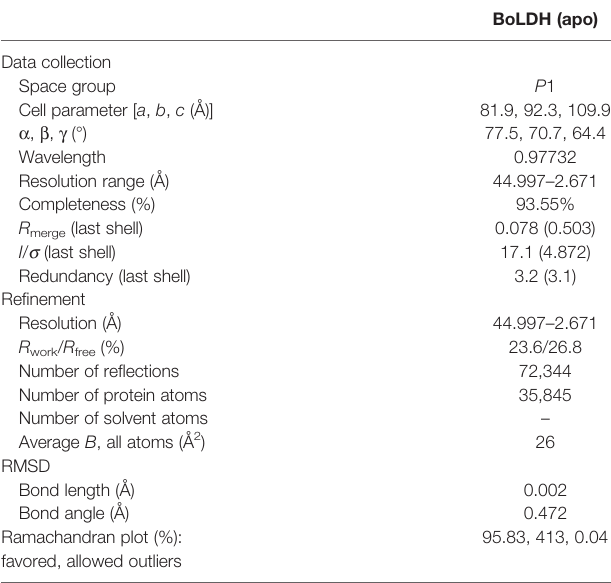
TABLE 1 | Statistics of data collection and re fi nement.